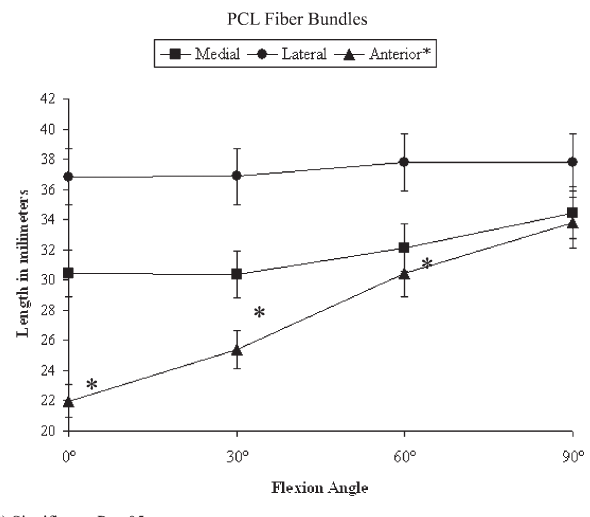
Figure 6 - Fiber bundle length changes of the posterior cruciate ligament with flexion angle